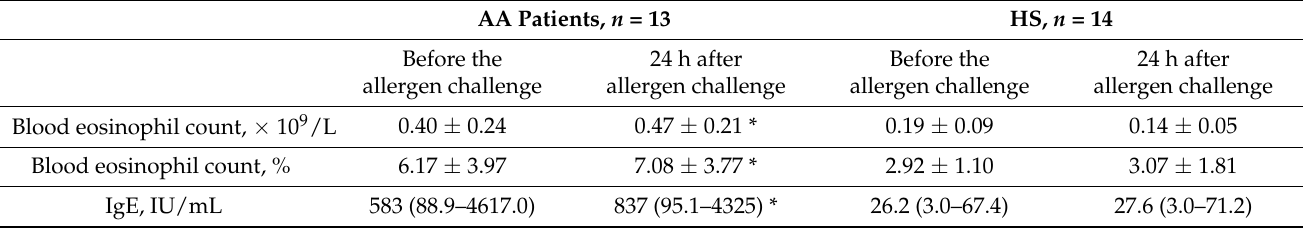
Table 4. Clinical characteristics of the study population 24 h after bronchial challenge with D. pteronyssinus . AA Patients, n = 13 HS, n = 14 Before the 24 h after Before the 24 h after allergen challenge allergen challenge allergen challenge allergen challenge Blood eosinophil count, × 10 9 /L 0.40 ± 0.24 0.47 ± 0.21 * 0.19 ± 0.09 0.14 ± 0.05 Blood eosinophil count, % IgE,